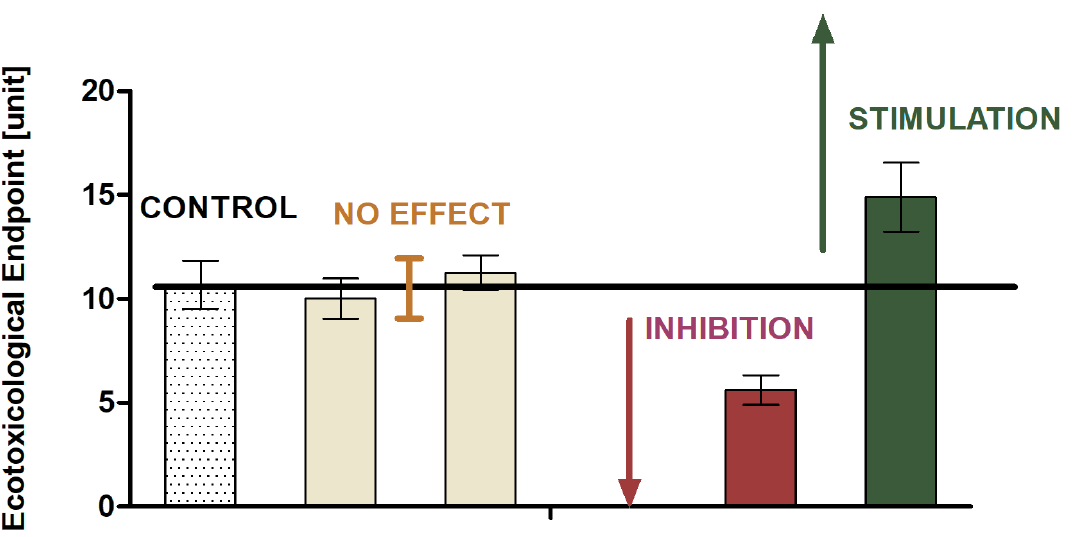
Figure 2. Inhibition/stimulation effect in ecotoxicological